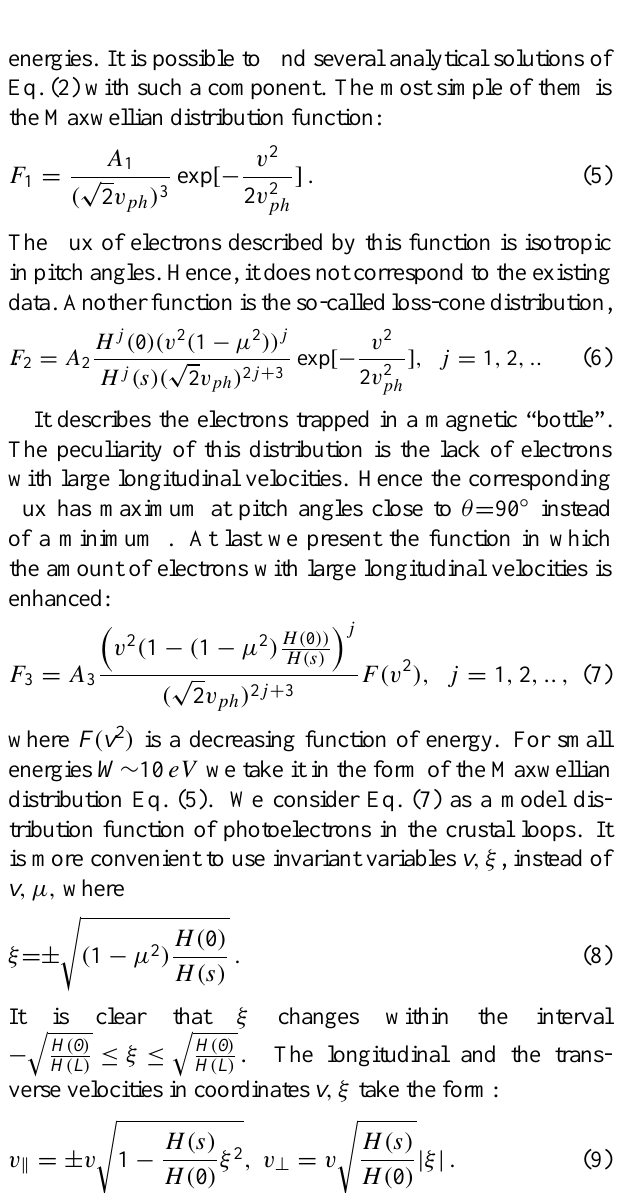
Fig. 2. Loss-cone distribution function of thermal electrons on closed magnetic field lines in the Martian ionosphere. Shown are the differential directional fluxes averaged over pitch angle (dashed curve) and transverse fluxes (solid) as a function of electron energy. The curves are based on Eq. (26). Both axes are in logarithmic